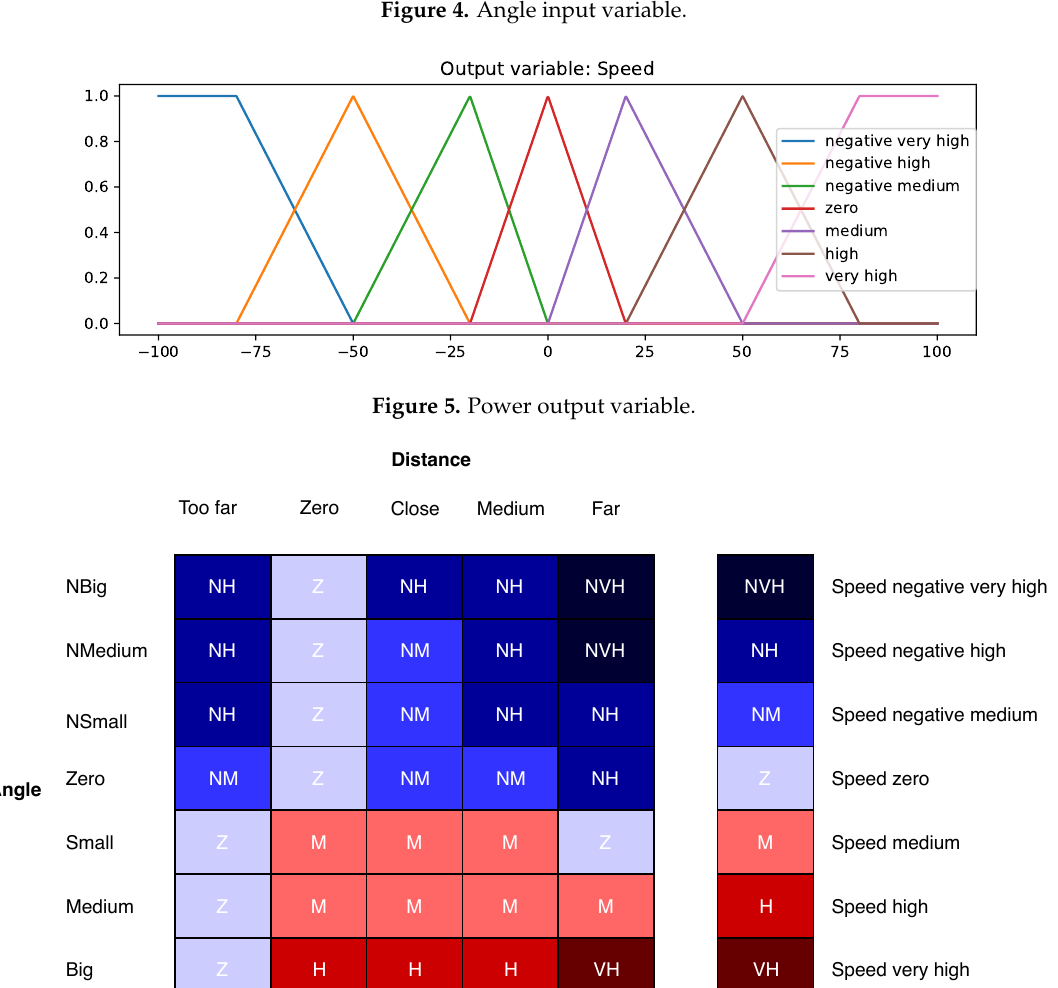
Figure 4. Angle input variable.